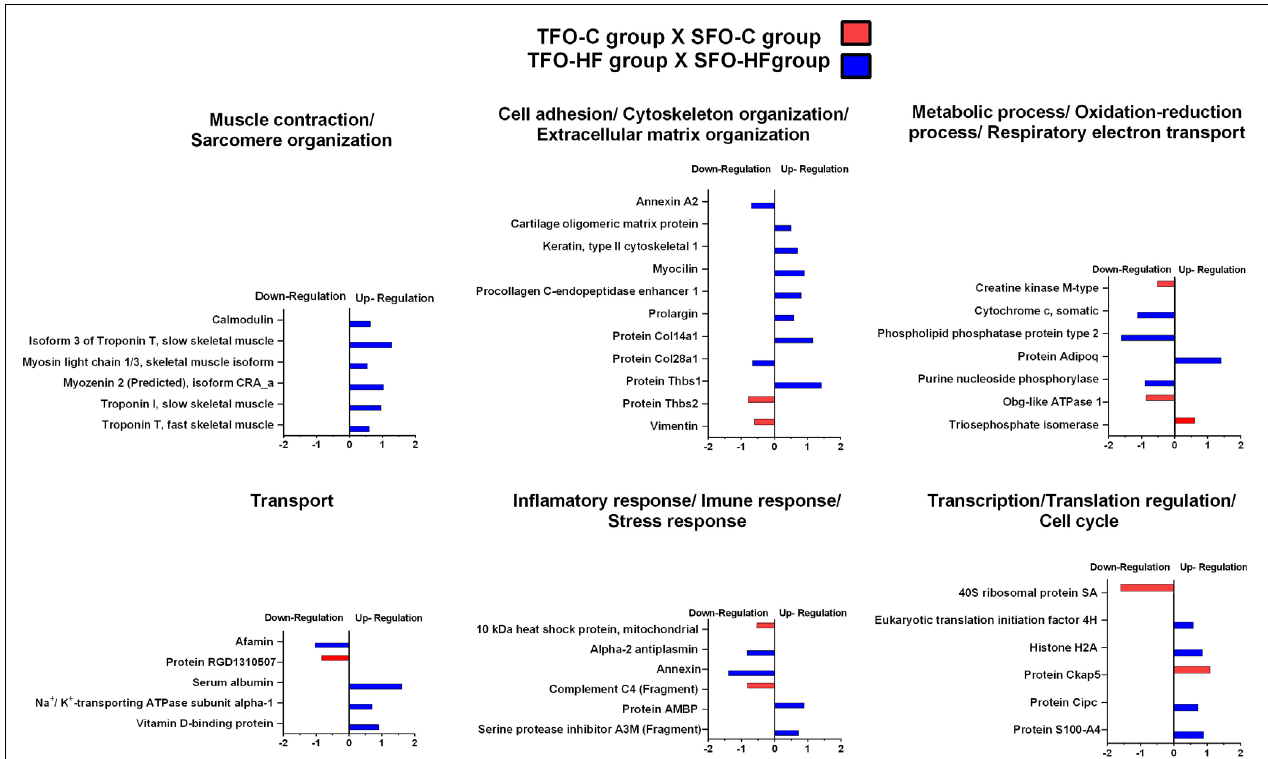
FIGURE 6 | Effects of paternal resistance training on tendon proteome in the offspring exposed to control and high-fat diet. Histogram of protein abundance levels from intergroup analysis considering only proteins with down-regulation and up-regulation ( p ≤ 0.05), with a ln(fold change) of at least ( ≥ ) 0.5. TFO-C, offspring from trained fathers exposed to control diet; SFO-C, offspring from sedentary fathers exposed to control diet; TFO-HF, offspring from trained fathers exposed to a high-fat diet; SFO-HF, offspring from sedentary fathers exposed to high-fat diet; The X -axis represents the natural logarithm of the ratio between the treatments (red: TFO-C:SFO-C ratio, blue: TFO-HF:SFO-HF ratio) . All altered proteins are grouped according to their biologic process as noted in Gen Ontology (GO). The proteins were considered reliably identified only if presenting an FDR < 1% and at least two matching peptides. Supplementary Data 3 shows detailed information about each protein outlined in this figure.